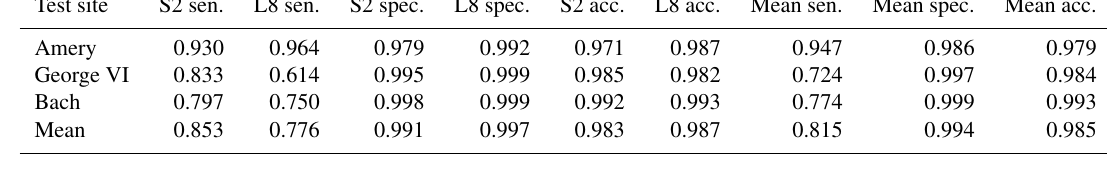
Table 1. Sensitivity (sen.), specificity (spec.) and accuracy (acc.) of the S2 and L8 methods for each of the test sites: Amery, George VI and Bach ice shelves and the mean values across sensors and sites for each.